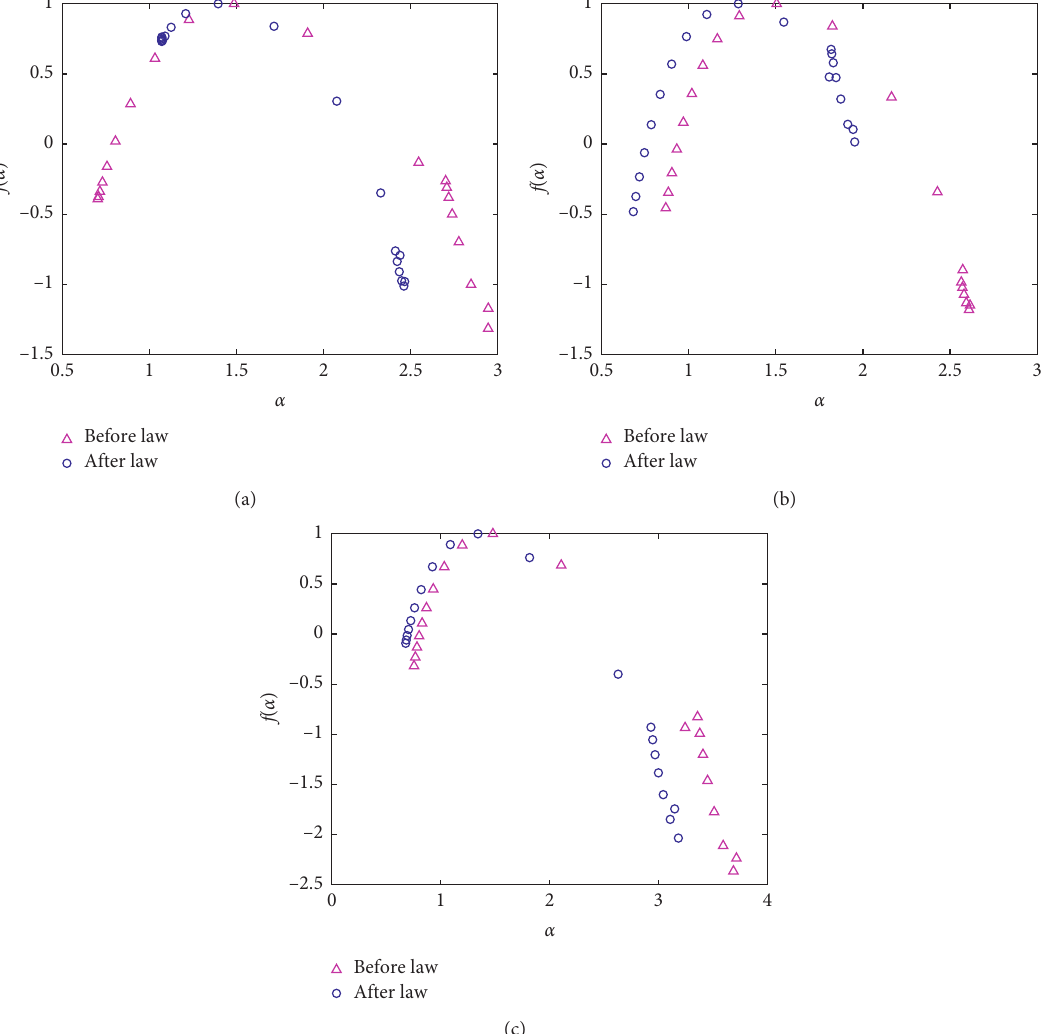
Figure 11: Holder exponent of PM concentration of (a) Seoul, (b) Busan, and (c) Daegu. The triangle and circle symbols represent before 2 . 5 and after the law,